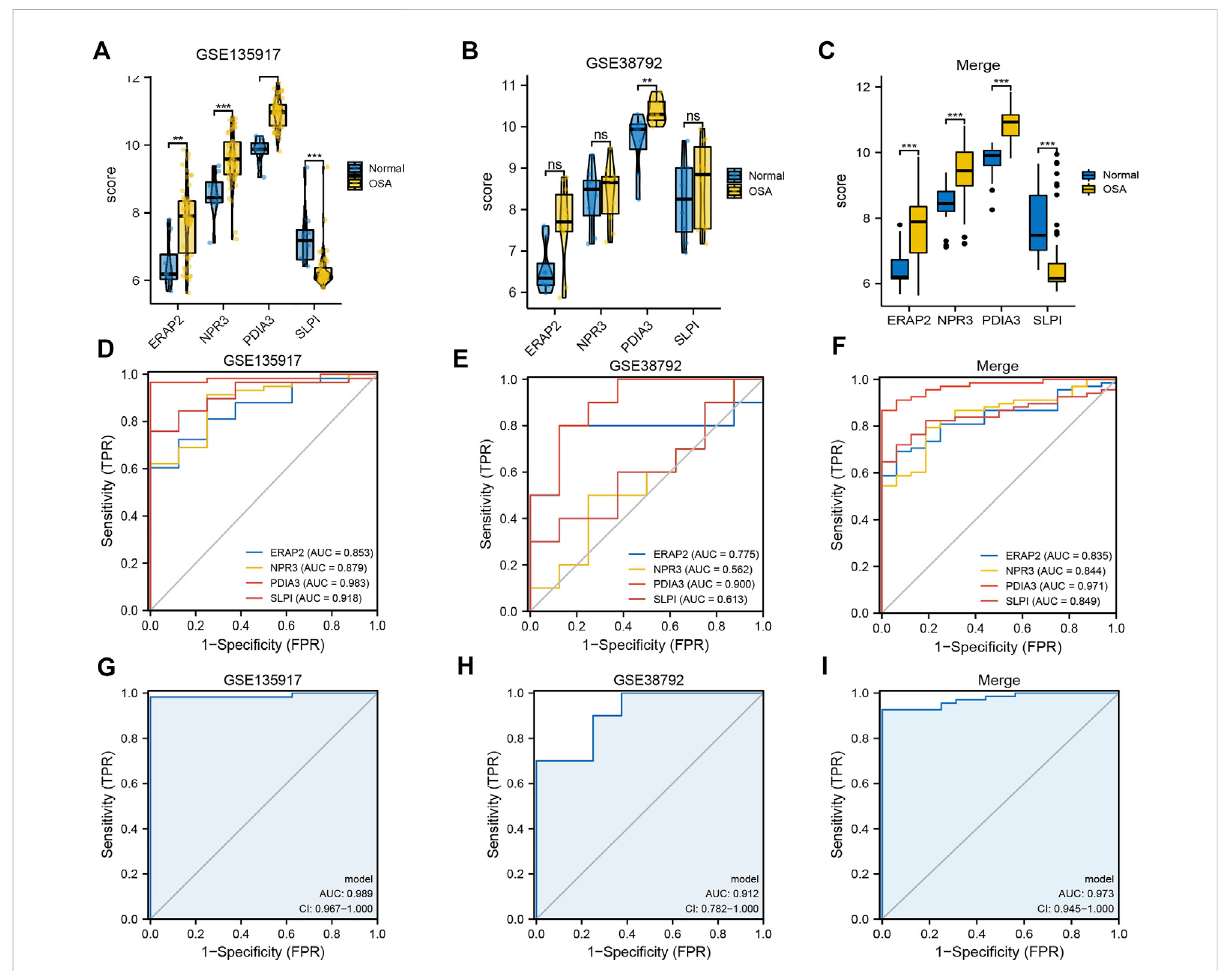
FIGURE 4 Expressiondifferencesanddiagnosticvalueofmitochondrialdysfunction-relatedfour-genediagnosticmodel.BoxplotsofdifferencesinNPR3, PDIA3, SLPI, and ERAP2 expression between OSA and control samples in (A) GSE135917, (B) GSE38792, and (C) combined datasets. ROCcurves of NPR3, PDIA3, SLPI, and ERAP2 in (D) GSE135917, (E) GSE38792, and (F) combined datasets. ROC curves of four-gene diagnostic model in (G) GSE135917, (H) GSE38792, and (I) combined